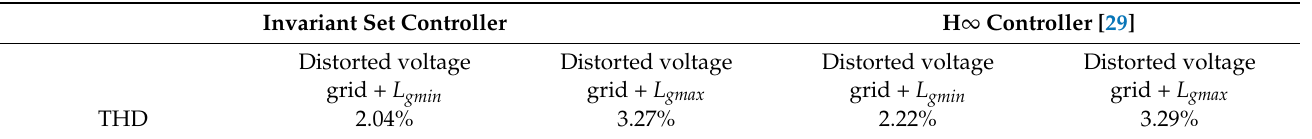
Table 6. Comparing the distorted voltage grid’s THD using the suggested controller and the H ∞ controller at L gmin and L gmax .